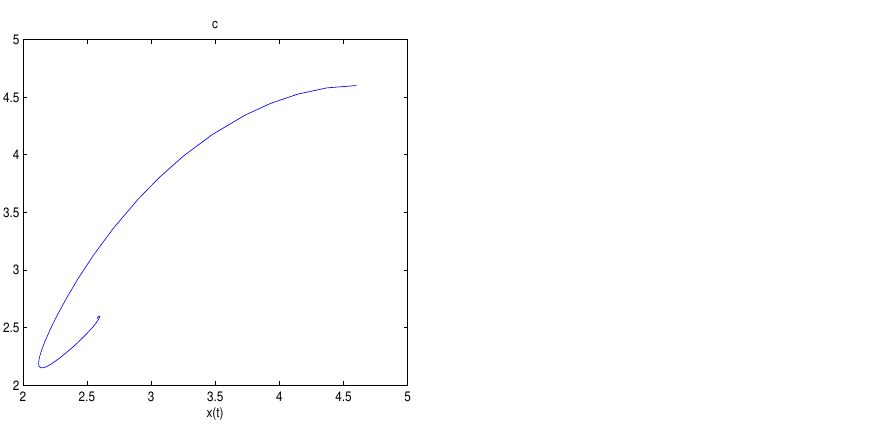
Figure 9. O is locally stable. A 2 (1.75, 1.75) is a saddle. A 3 (2.581, 2.581) is locally stable. The trajectory tends to A 3 when the initial value is ( x ( 0 ) , y ( 0 )) = ( 4.6,4.6 ) . In here r = 2, ω = 0.414, b = 0.5, c = 2.87, α = 1.674. Subfigure ( a ) is time series of x ( t ) , subfigure ( b ) is time series of y ( t ) and subfigure ( c ) is phase diagram of system (9).